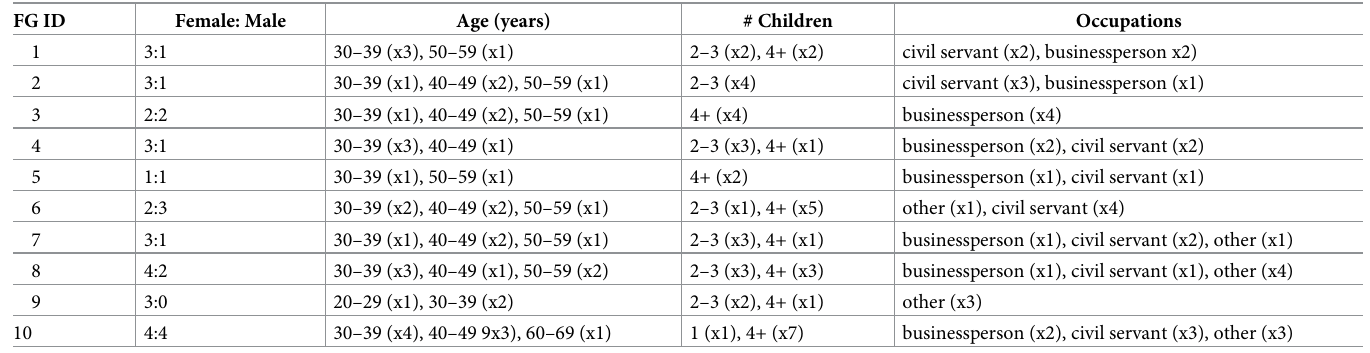
Table 2. Characteristics of focus group participants (n = 44).